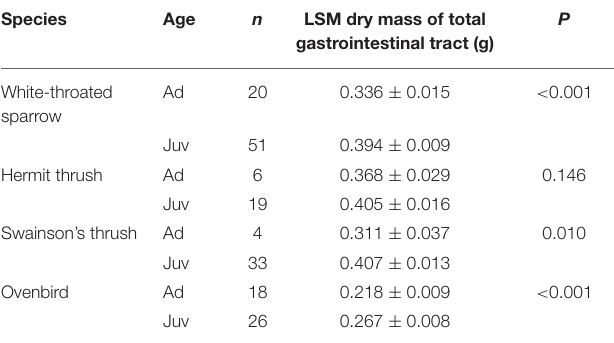
TABLE 2 | Least square means ( ± SE) dry masses of total gastrointestinal tracts from adults (Ad) and juveniles (Juv) of four migrant bird species collected during fall migration (2008–2011).